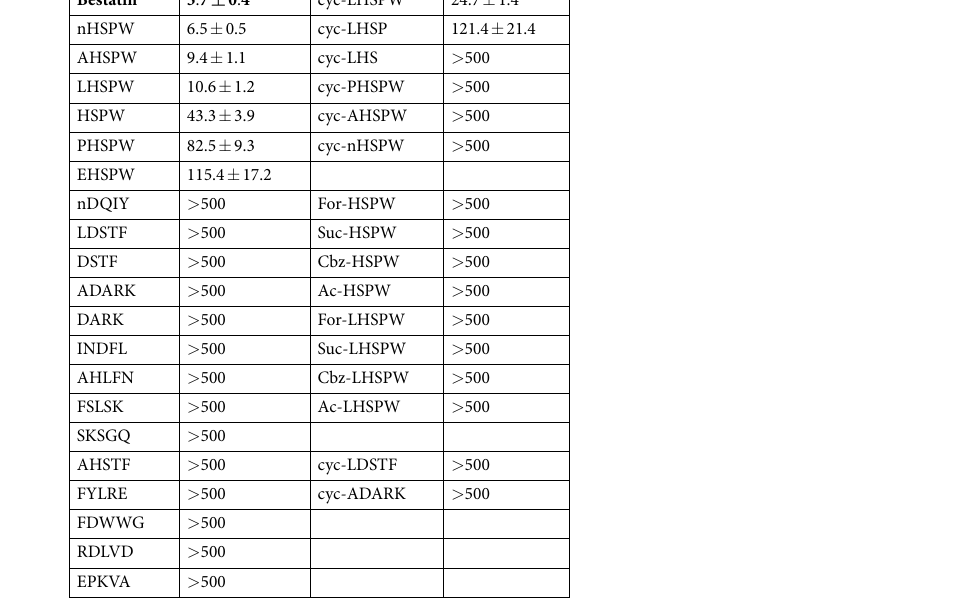
Table 1. List of Aminopeptidase N inhibitor